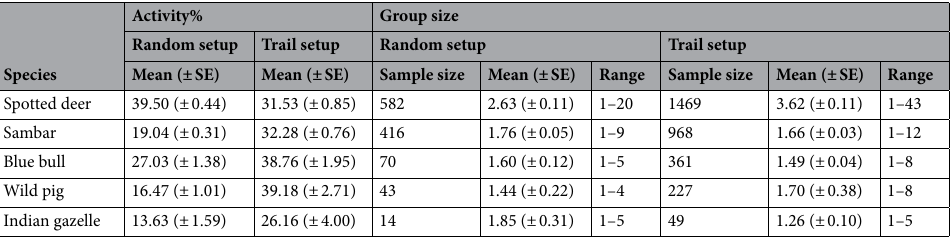
Table 2. Comparison of percent amount of time a species is active and estimates of group size of wild ungulates obtained from random and trail camera setups.